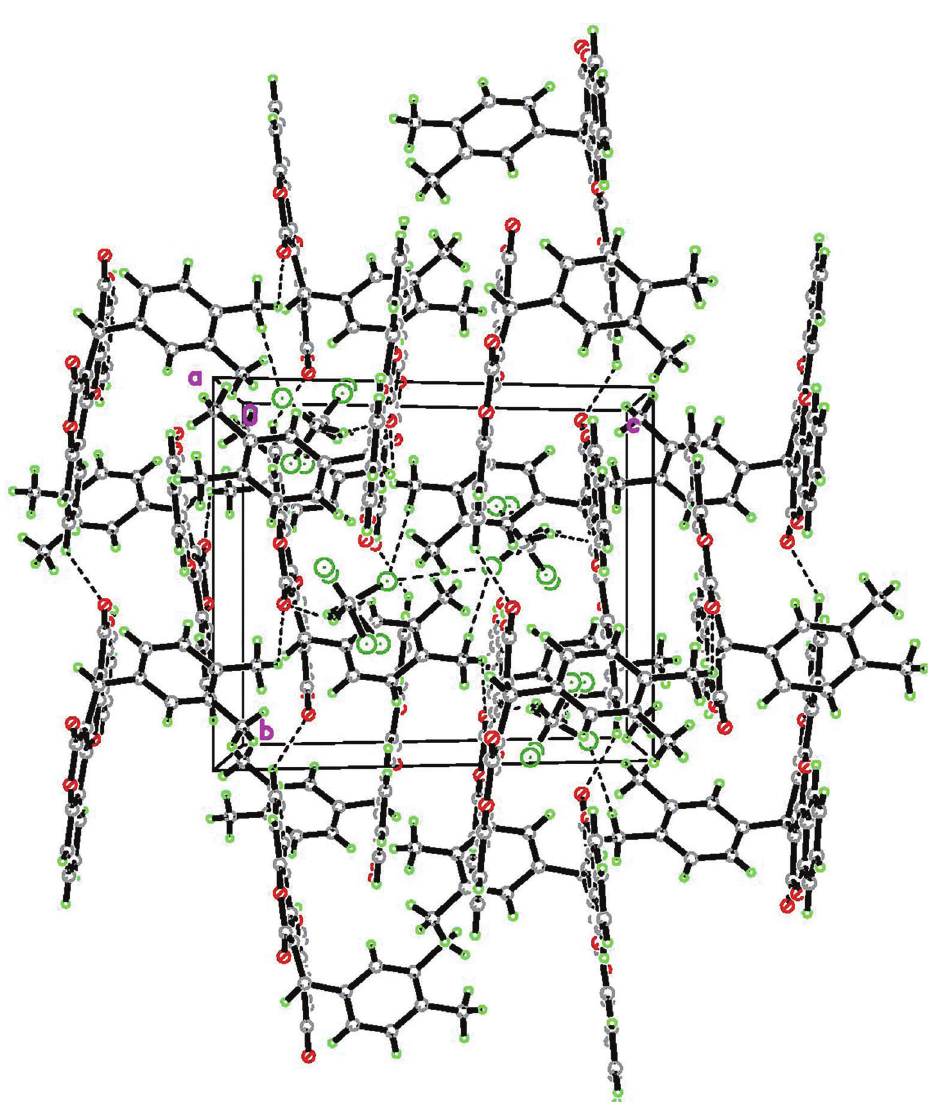
Figure 3. Crystal packing structure of compound I b along the a